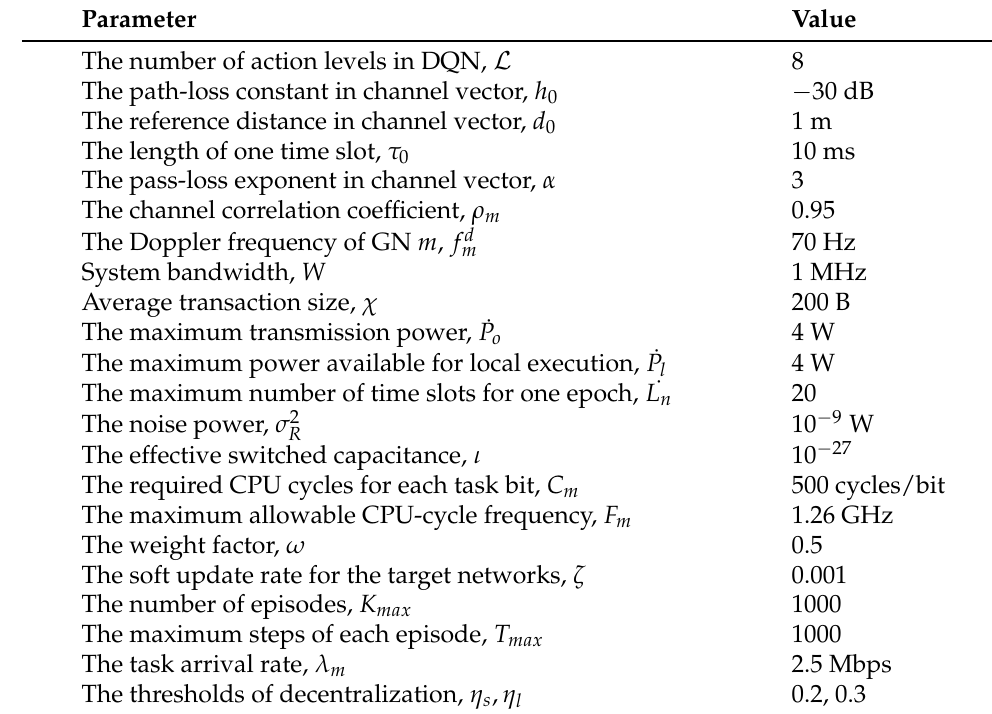
Table 3. Simulation